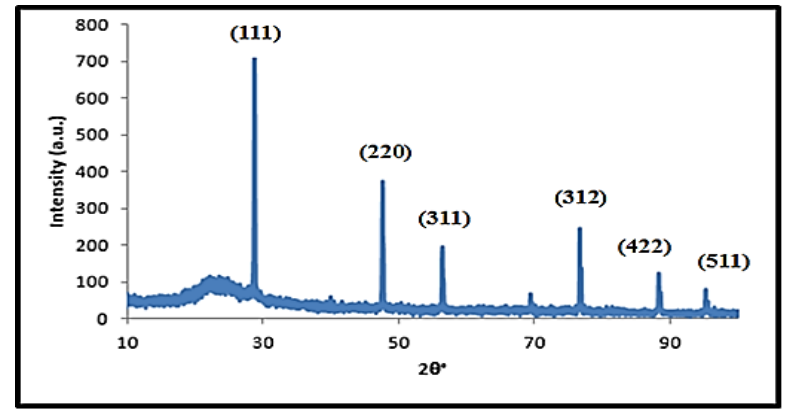
Figure 1. X-ray diffraction pattern of the prepared NPS powder.